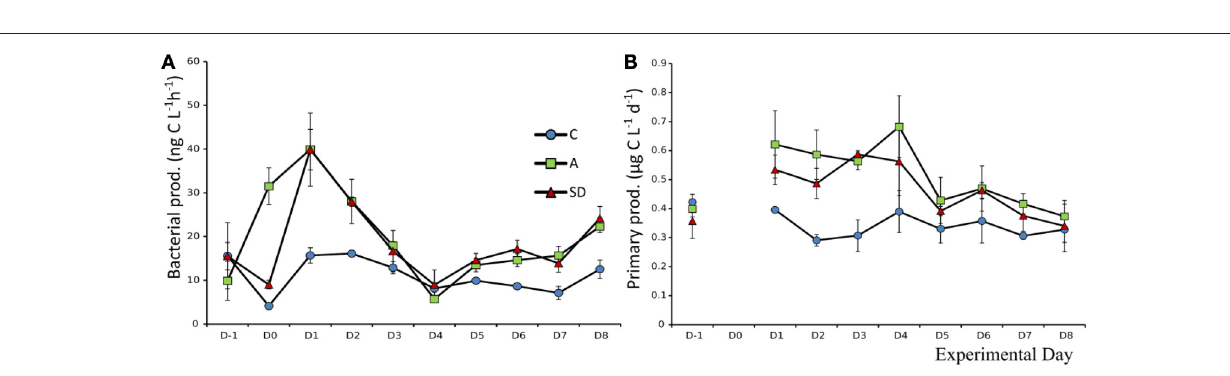
FIGURE 7 | Bacterial production (A) and primary production (B) in each